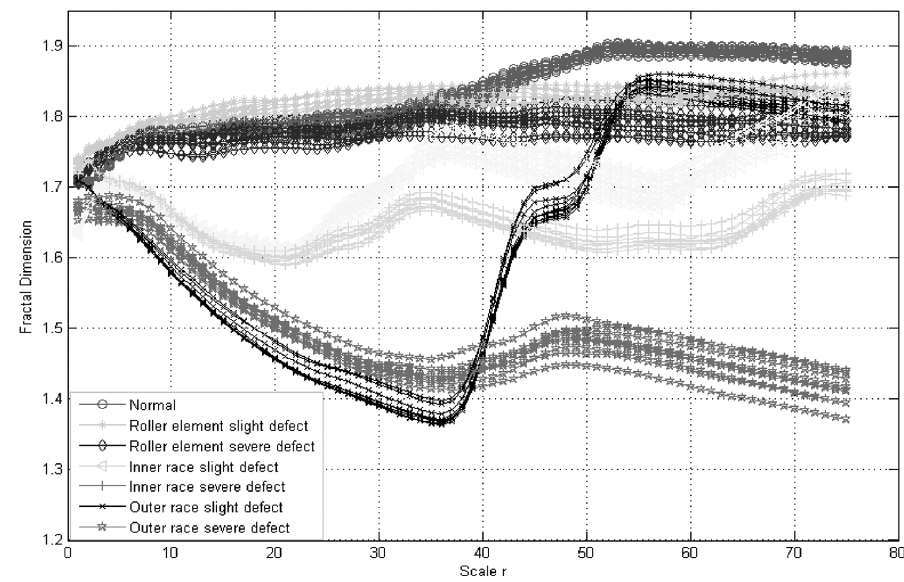
Fig. 6. Multi-scale fractal dimensions of seven bearing